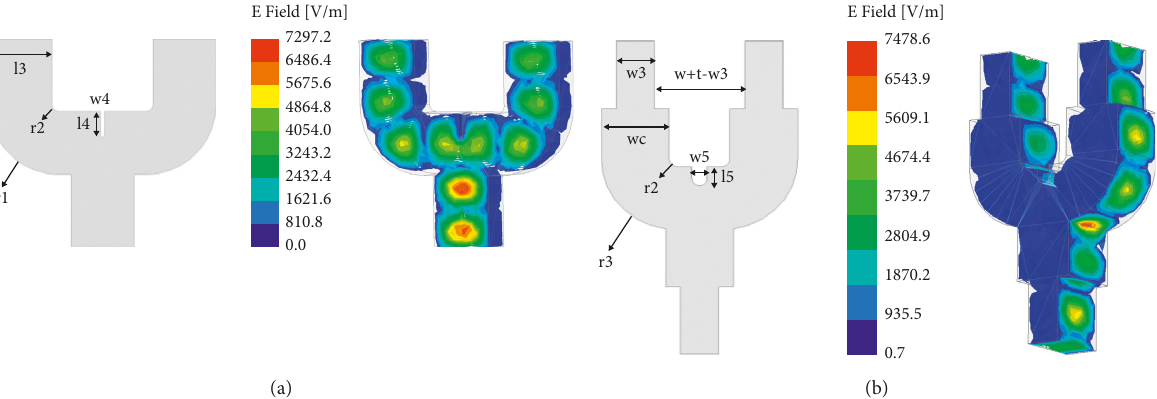
Figure 4: Schematic and electric field distribution of the (a) E-plane power divider and (b) H-plane power divider. w 3 l 3 8.636mm, w 4 (cid:29) r 3 (cid:29)